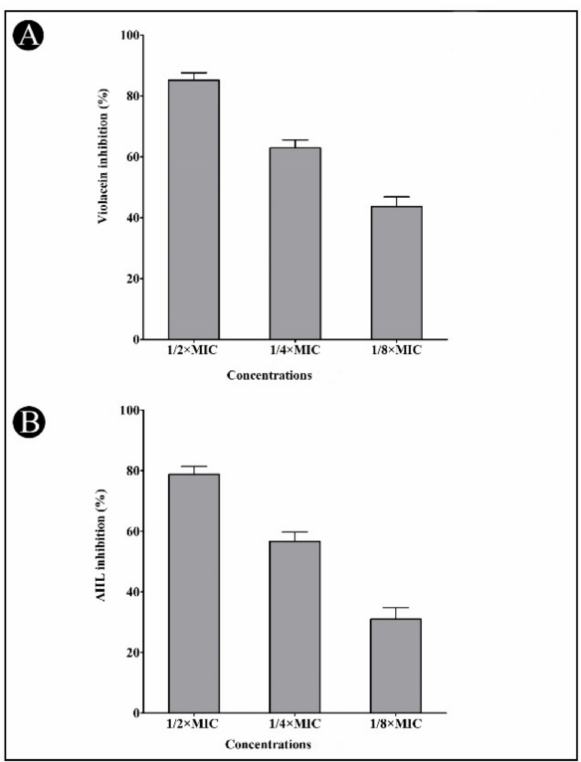
Figure 5. Inhibition of violacein ( A ) and AHLs ( B ) by synthesized AgNPs in C. violaceum at the sub-MIC concentrations (1/2, 1/4 and 1/8 MIC). Values are presented as mean ± SD of three independent